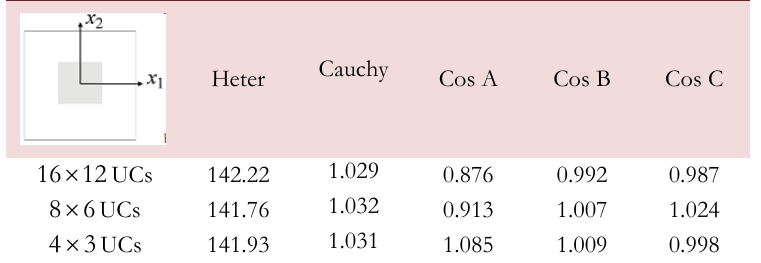
Table 2: Structural stiffness in the case of different assemblages of UC2: Heter = micromechanical model; Cauchy= homogenized first order model; Cos A = homogenized Cosserat with Procedure A ; Cos B = homogenized Cosserat with Procedure B ; Cos C = homogenized Cosserat with Procedure C